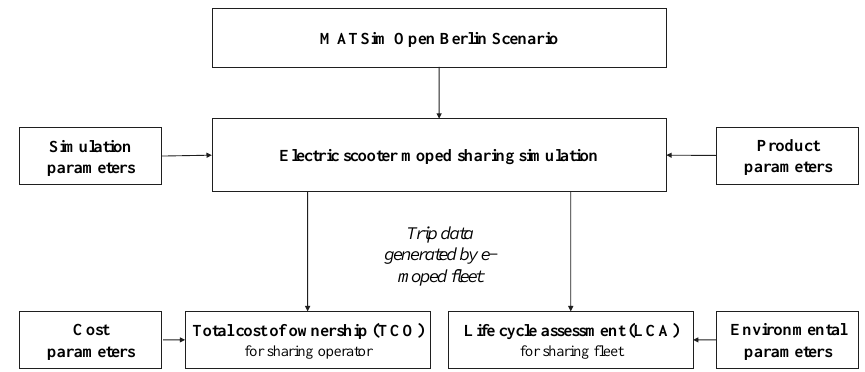
Figure 1. Flow chart of the methodology